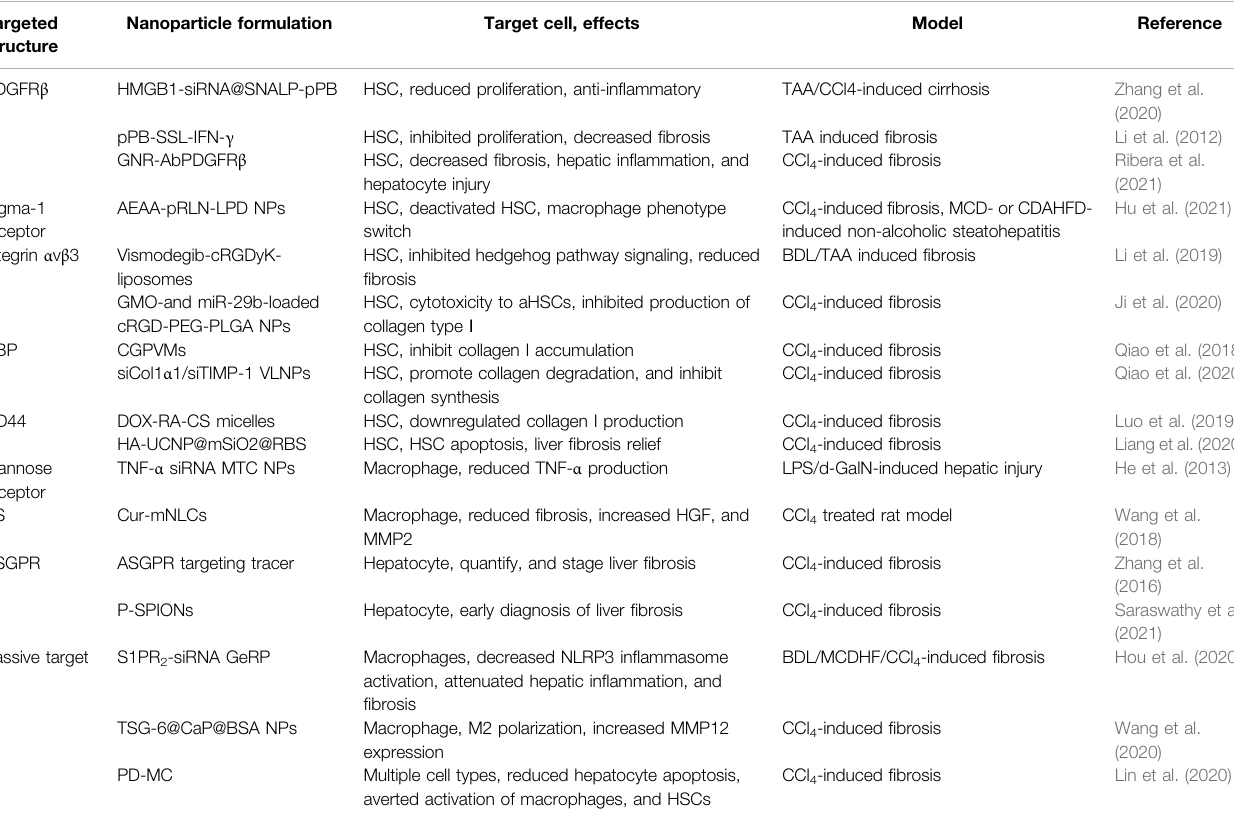
TABLE 1 | Preclinical nanomedicine for liver fi brosis. Targeted